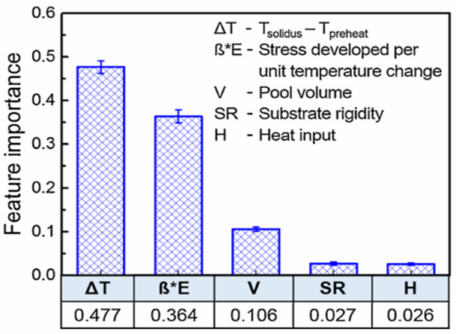
Figure 36. Feature importance of causative parameters. Reprinted with permission from Ref. [10].